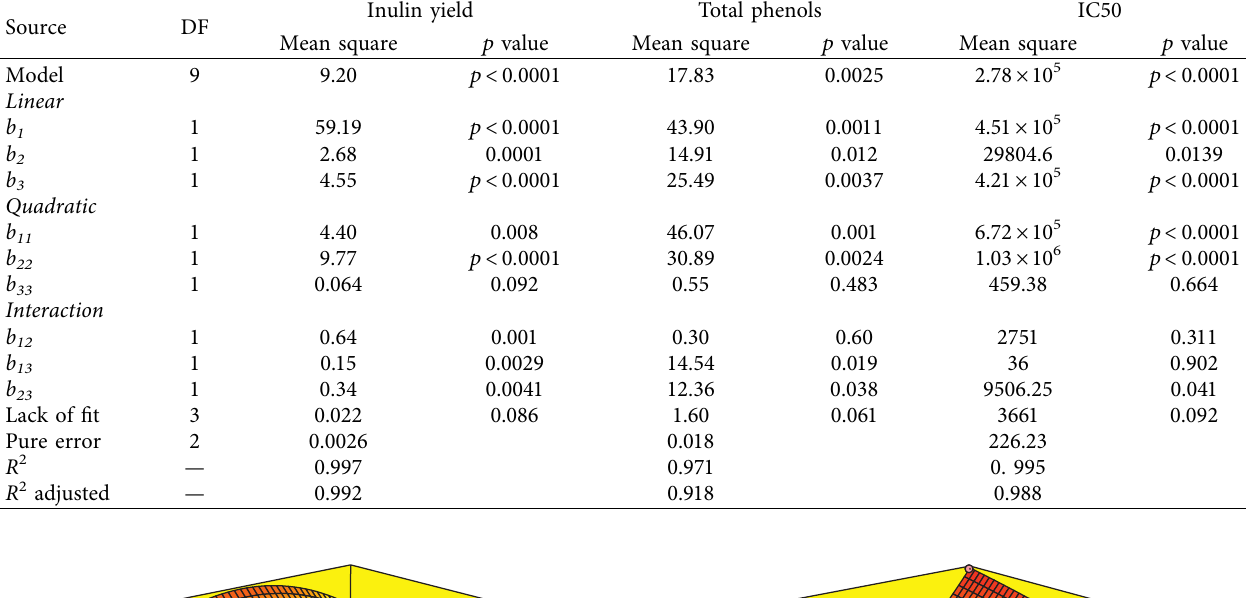
Table 1: Table of ANOVA for the experimental variables as linear, quadratic, and interaction terms of each response variable. Source DF